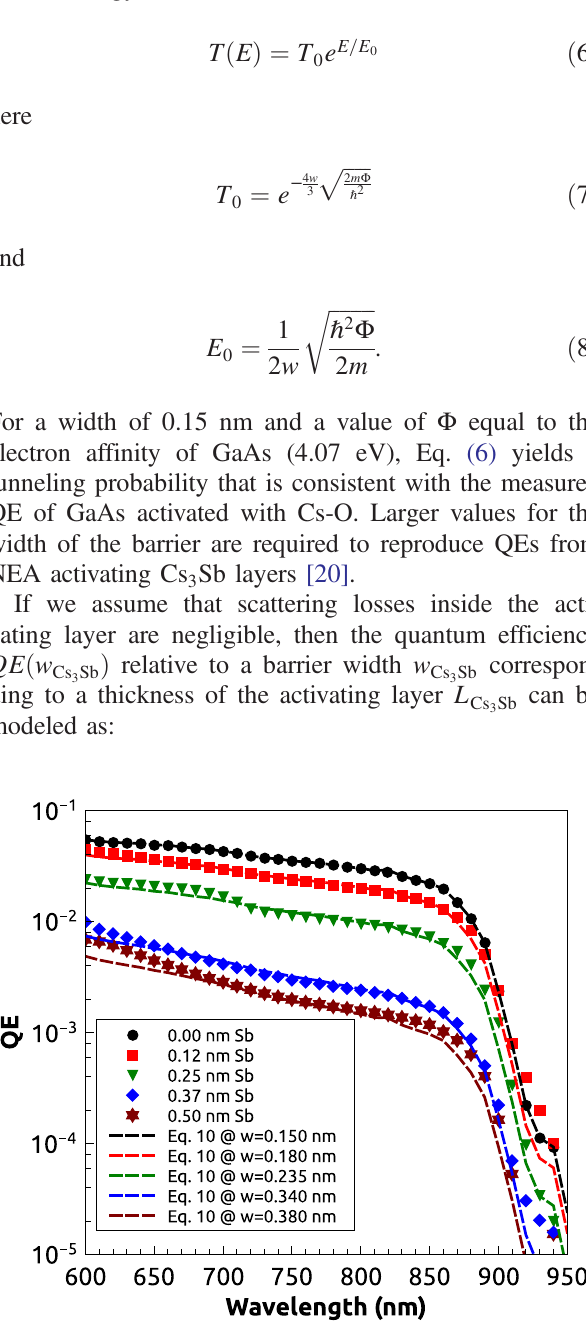
FIG. 10. Spectral response of the samples activated to NEA with Cs 3 Sb and the corresponding prediction of Eq. (10). Barrier thicknesses are given in Table